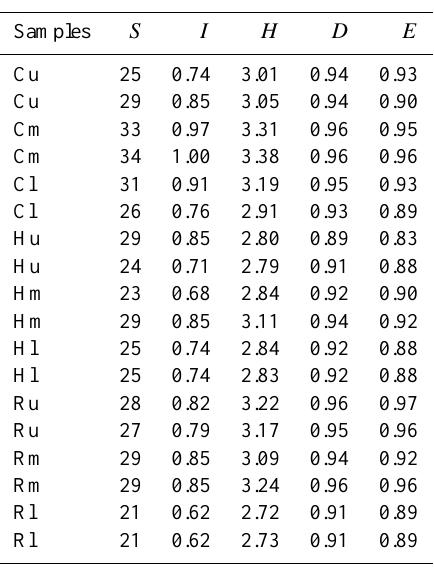
Table 2. The biodiversity indices of the soil sampled from the upper ( u ), middle ( m ), and lower ( l ) layers of the control ( C ), raw waste ( H ), and treated waste ( R ) contaminated columns.